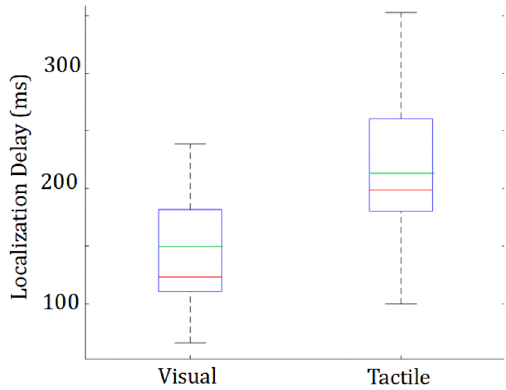
Figure 3. Stimulus spatial localization RT. The difference of the total visual and tactile RT (Fig. 2) relative to the corresponding NOMAP RT provides us with an estimate of the part of the RT representing the stimulus localization time. The median is displayed in red, the mean in green and the first and third quartiles in blue. There were no outliers (non analyzed)